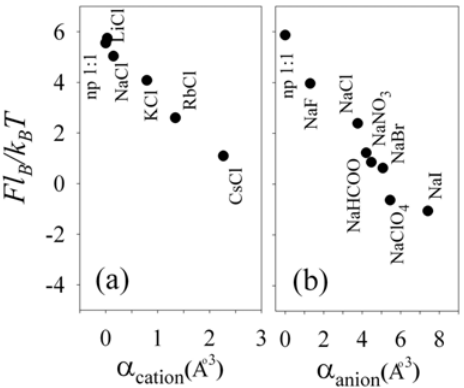
Fig. 2 – Effect of counterion identity on the potential of mean force between two macroions at a fixed distance ( r = 1 . 3 σ m ) in a solution of ionic strength 0.125 M. In (a), the macroion net charge number is − 20, the counterions are cations. In (b), the macroion net charge number is + 20, the counterions are anions. Raising counterion polarizability, increases the attraction between two macroions (Tavares et al.